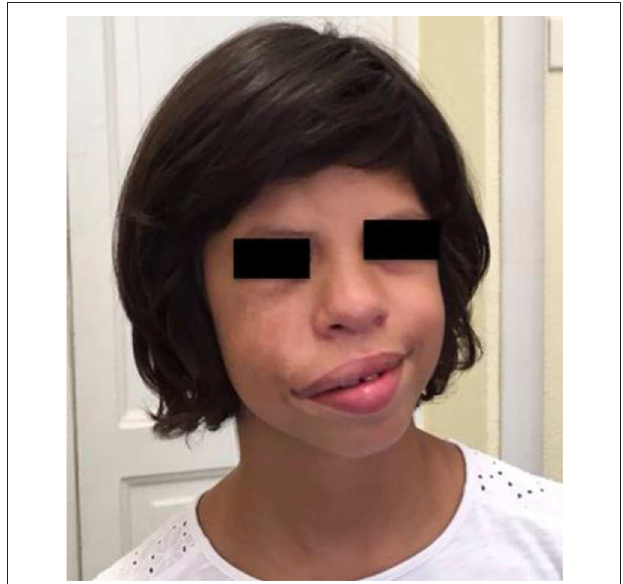
FIGURE 2 | The patient at the age of 7 years. the physical examination showed progressive facial asymmetry with right hypoglobus and enophthalmos that had never been reported during her first years of life.